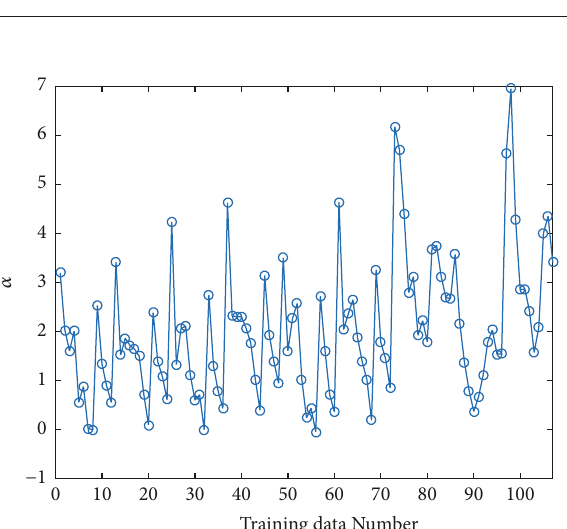
Figure 7: The effect of spread constant on GRNN model.